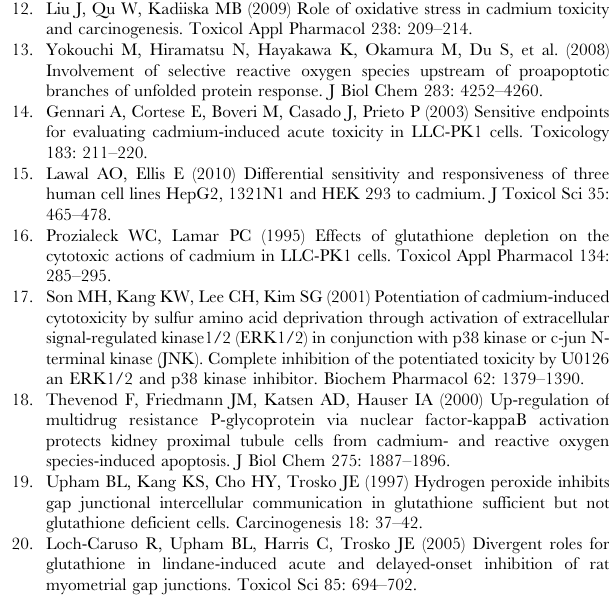
Figure S1 Densitometric analysis of time-course effect of cadmium on Cx43-EGFP (A) and phosphorylated Cx43 levels (B) shown in Fig. 1A. Results were expressed as fold of induction relative to the basal level of Cx43-EGFP in Fig. A (mean 6 S.D., n= 3). # p , 0.01 versus untreated control. In Fig. B, results were expressed as fold of induction relative to the phosphorylated level of Cx43 at 1 h because of the lack of visible phosphorylated band at zero point (mean 6 S.D., n= 3). #